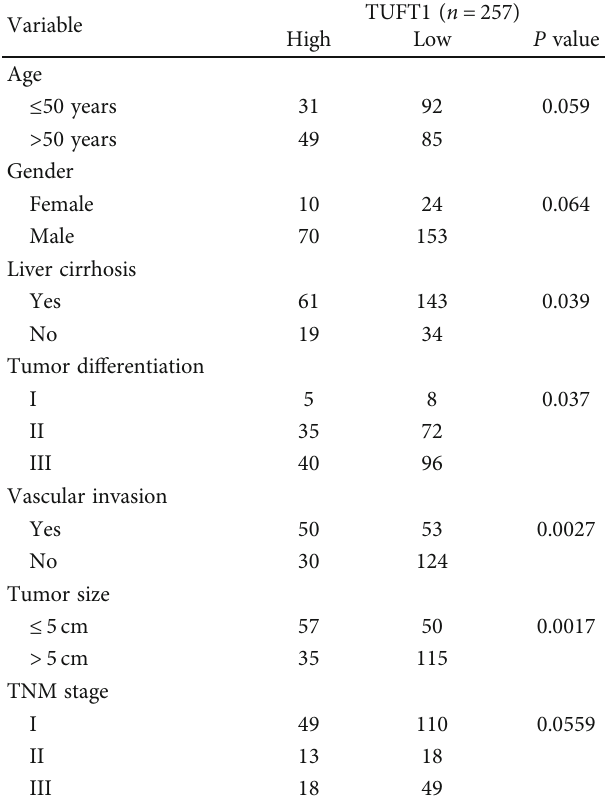
Table 1: Correlations of TUFT1 with clinical pathological features of HCC